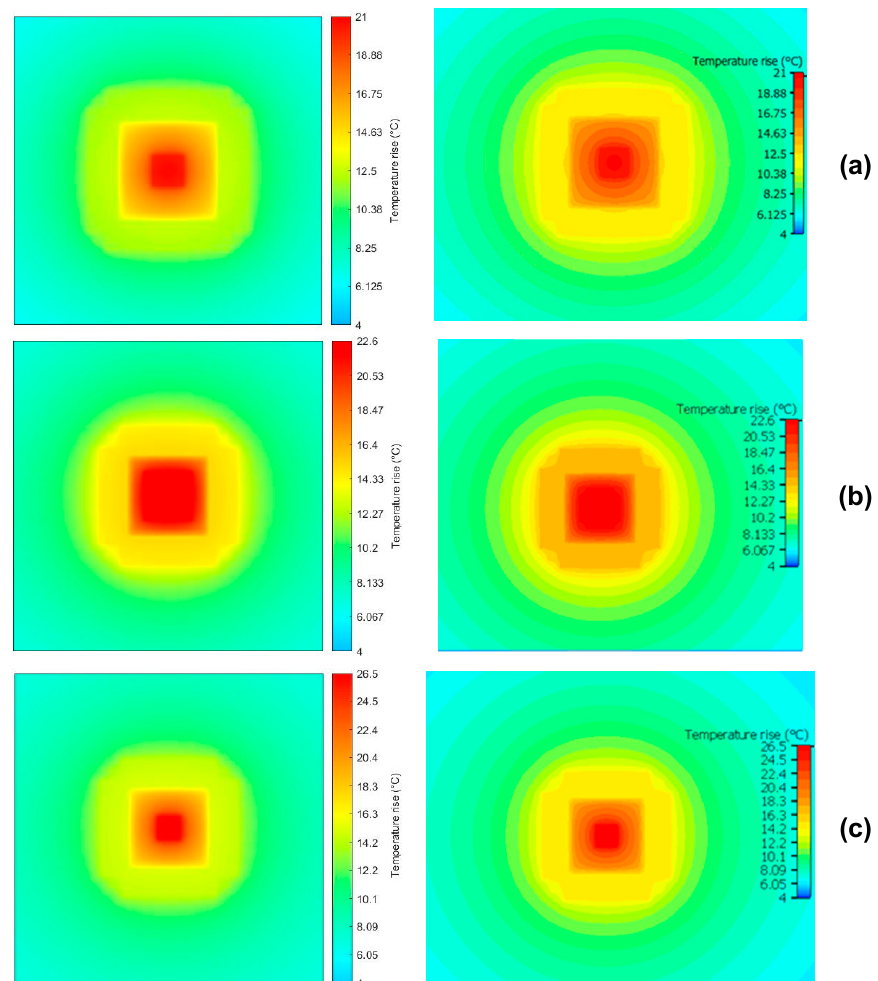
Figure 11. Temperature rise maps for three eTQFPs dissipating 1 W, as calculated by TRIC (left) and FloTHERM (right): ( a ) 14 × 14 mm 2 package size with a 9 × 9 mm 2 epad and a 3 × 3 mm 2 die; ( b ) 10 × 10 mm 2 package with a 6 × 6 mm 2 epad and a 4 × 4 mm 2 die; ( c ) 10 × 10 mm 2 package with a 6 × 6 mm 2 epad and a 2 × 2 mm 2 die. Energies 2020 , 13 , x FOR PEER REVIEW